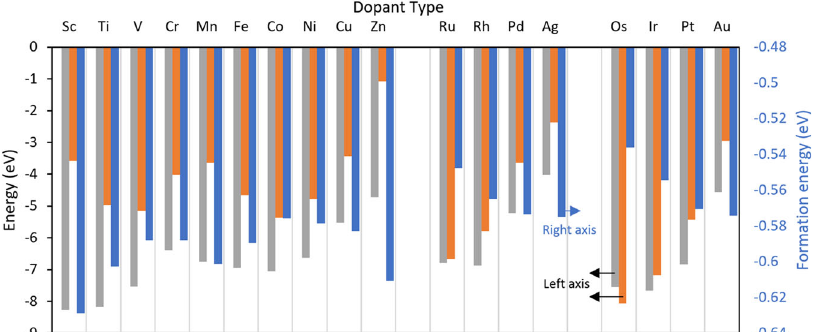
Fig. 3 Binding energy E b (gray column, left axis) of TM embedded into CdS catalyst, cohesive energy E c (orange column, left axis) of TM bulk, and formation energy E f (blue column, right axis) of TM@CdS catalyst. The order of the TM dopant from left to right goes from 3d series to 5d series. Data are available in Zenodo.